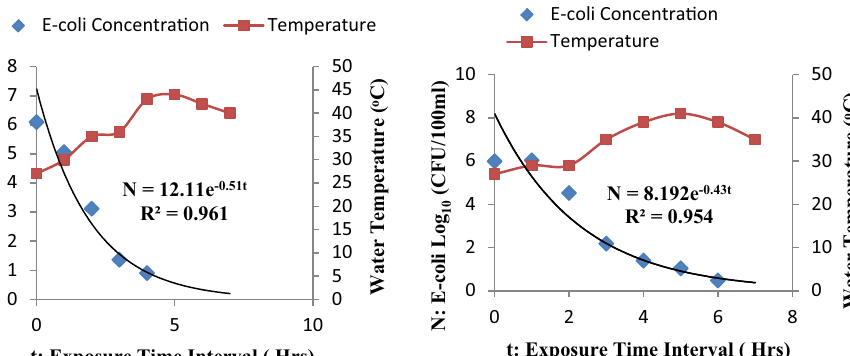
N = 12.11e -0.51t R² =